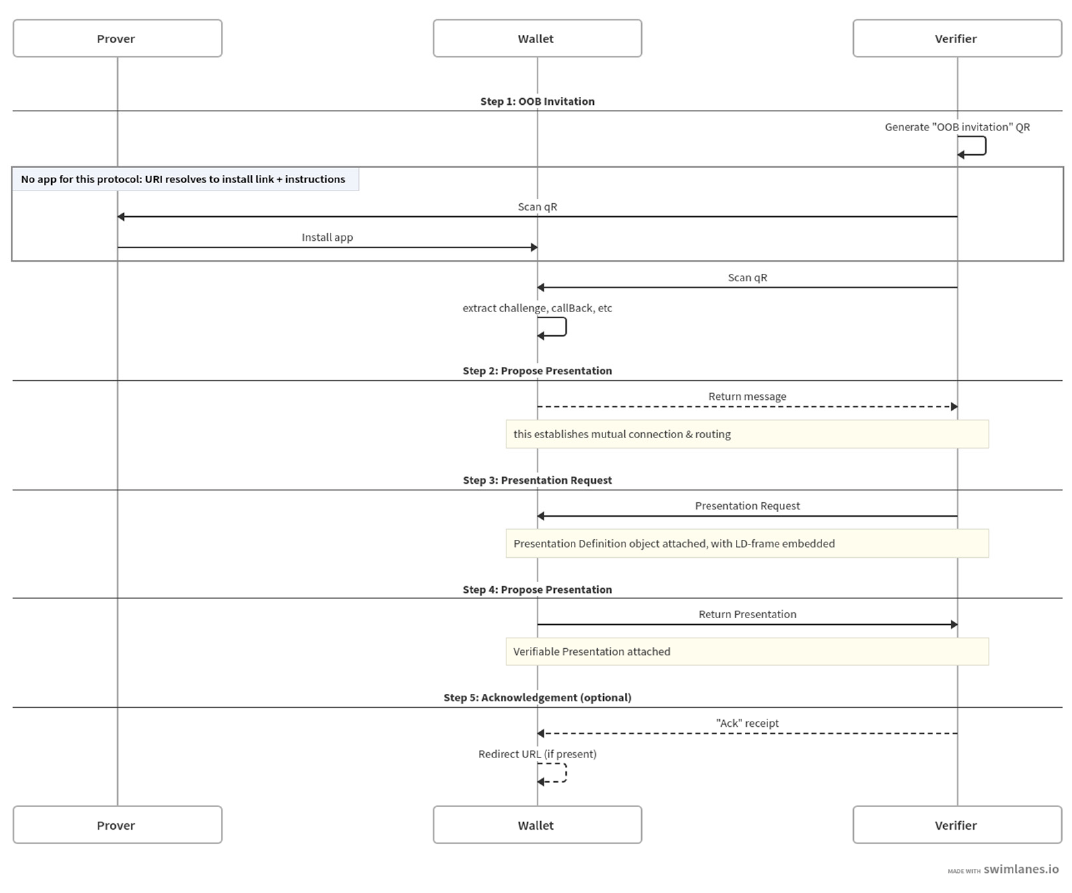
Figure 4. Overview of the WACI presentation interaction fl ow [17].